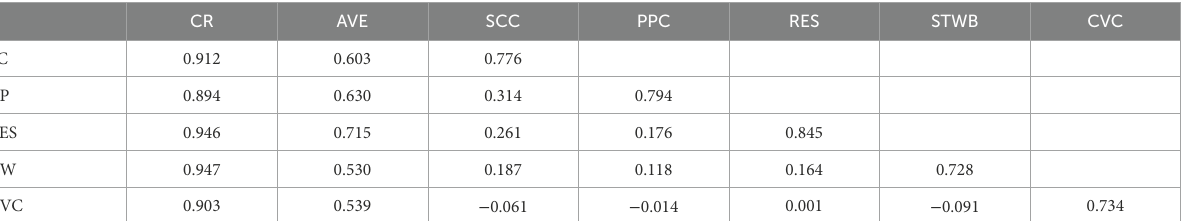
TABLE 3 Discriminant